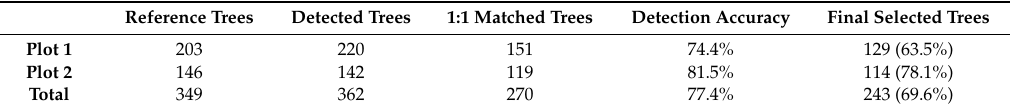
Table 2. Results of individual tree segmentation and sample tree